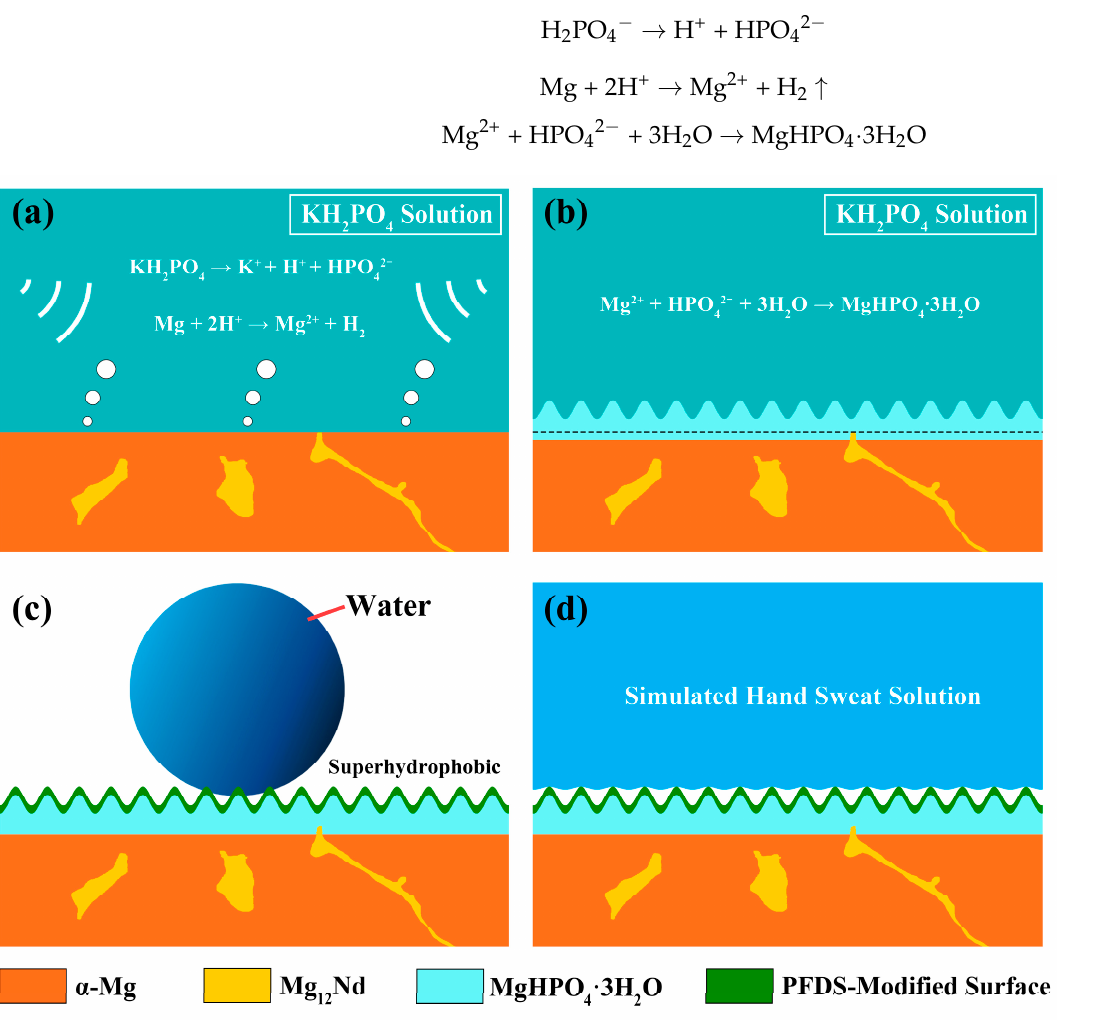
Figure 11. ( a , b ) Schematic diagram of the coating formation during ultrasonic-assisted chemical conversion; ( c ) superhydrophobic surface on Mg-Nd alloy; ( d ) anti-corrosion mechanism in artificial hand sweat solution.